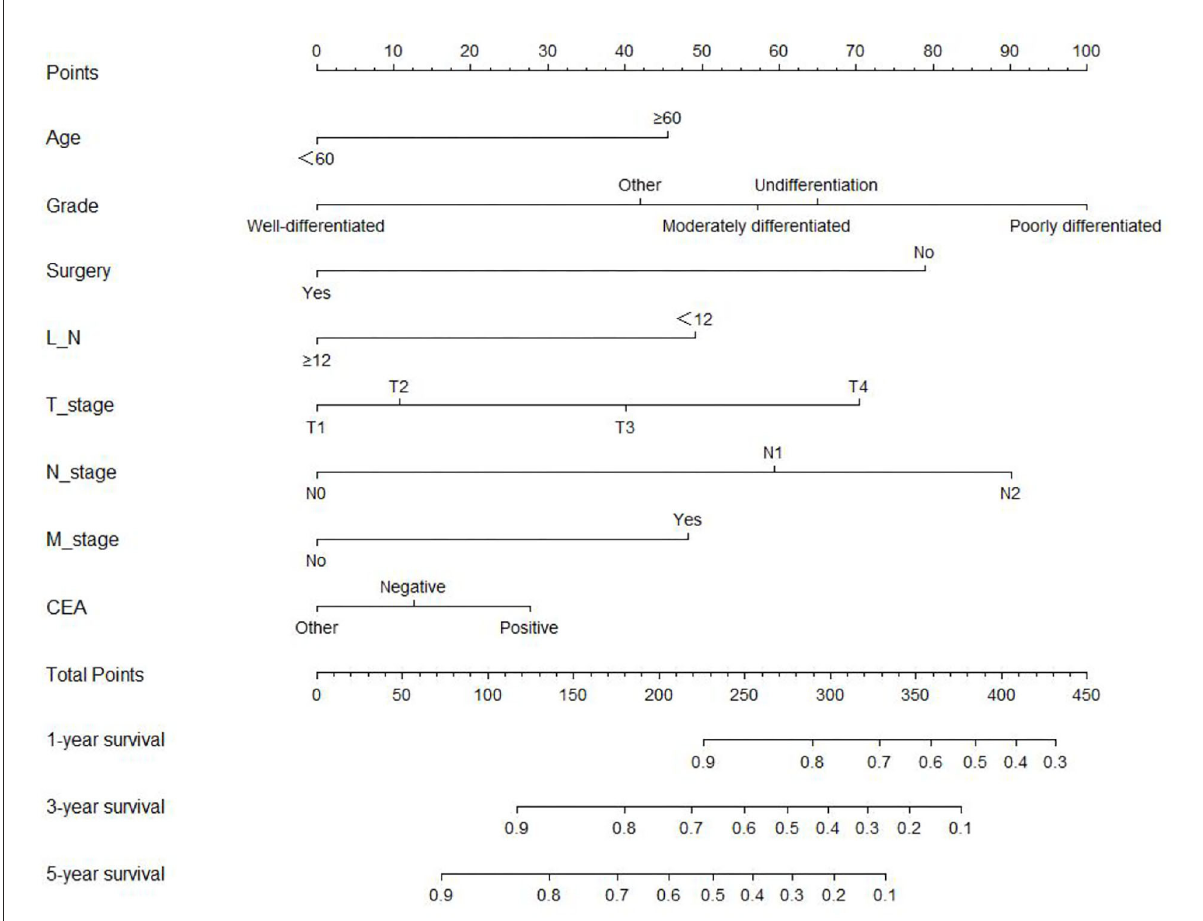
FIGURE2 Prediction model of the overall survival (OS) nomogram in appendix cancer patients.